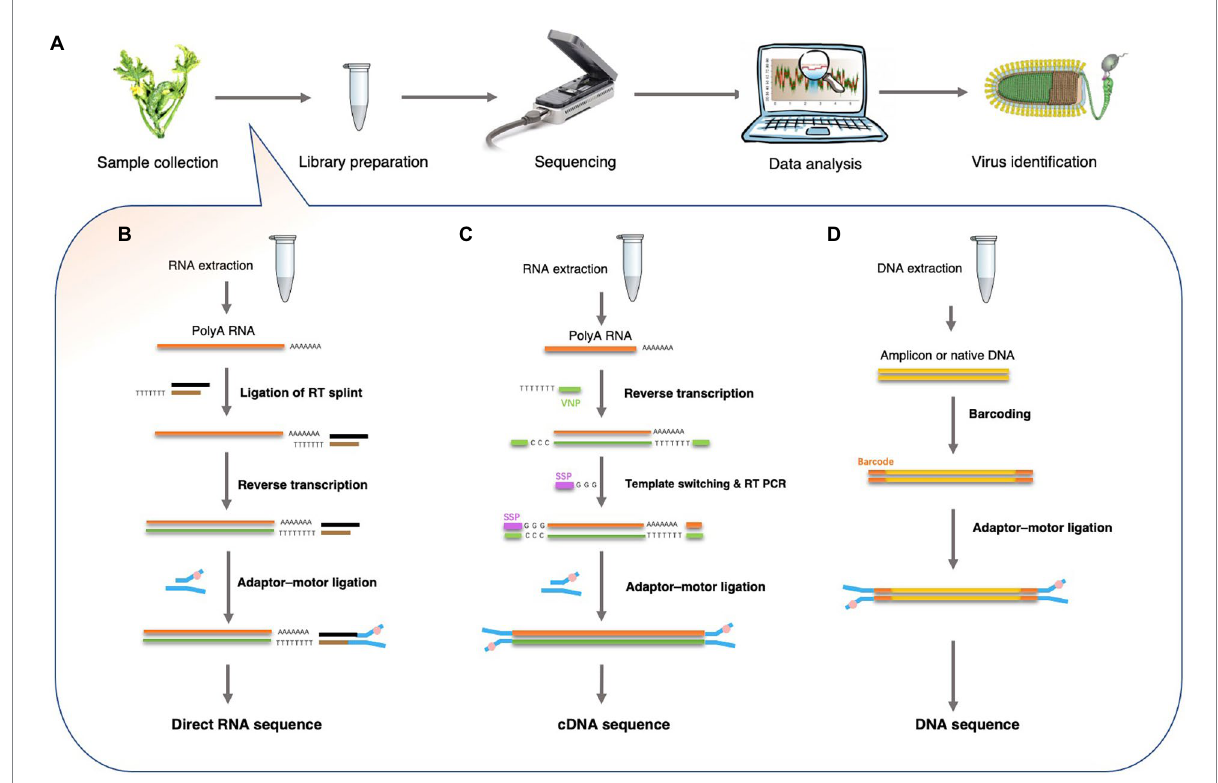
FIGURE 2 Overview of Nanopore sequencing and library preparation for plant virus detection. (A) Workflow for plant virus detection from sample collection to virus identification. (B) Direct RNA sequencing using the ONT-SQK-RNA001 library method with poly (A) RNA as a template. A reverse transcription step with oligo-dT primers was used to circumvent secondary structure of the RNA. A sequencing adapter was ligated to the mRNA using T4 DNA ligase. Since only the RNA strand is motor-ligated, only the RNA molecule is sequenced. (C) cDNA-PCR sequencing using the ONT- SQK-PCS108 library preparation method. Poly (A) RNA was used as a template for first strand cDNA synthesis with oligo-dT30VN primers (VNP). When first strand cDNA synthesis reaches the end of the RNA molecule, few non-templated Cs were added to the end of the cDNA by the reverse transcriptase. Then, a strand-switching primer (SSP) present in the reaction binds to the non-templated Cs, followed by enrichment. (D) DNA sequencing: the ONT-SQK-LSK108 library preparation method. The Barcoding Kit such as ONT-EXP-NBD103 can be used to tag the native DNA or amplicons DNA (after PCR or RCA